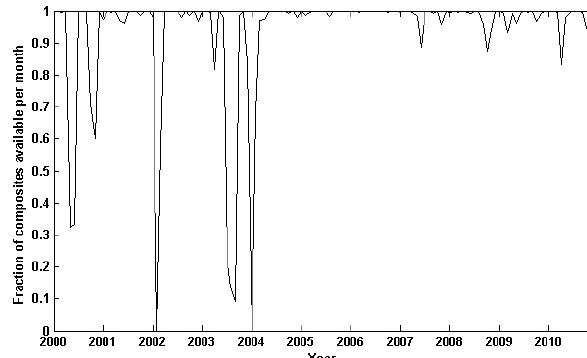
Figure A2. Availability of radar data as a function of